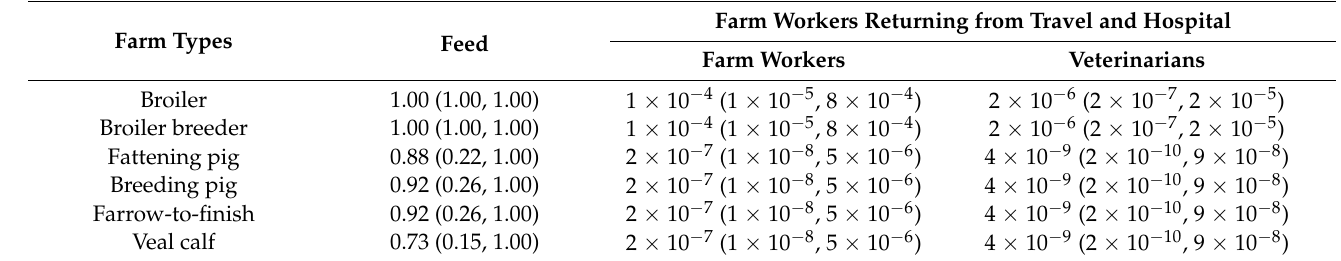
Table 1. Probability of at least one animal colonized on a farm given exposure of the farm to CPE. The companion animal source resulted in zero probability, and there was no calculation for imported livestock.